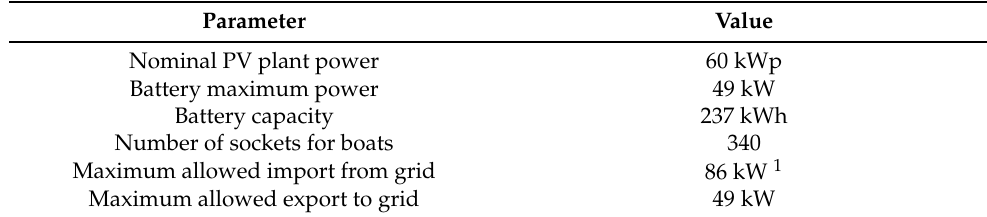
Table 1. Overview of Ballen marina